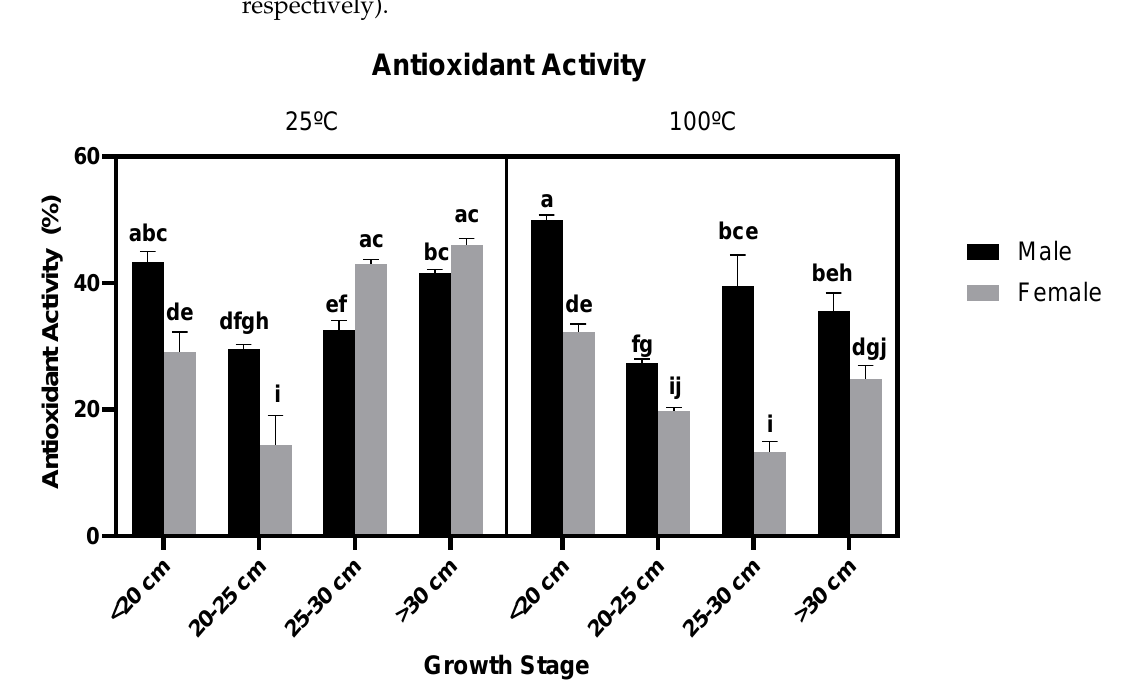
Figure 2. Antioxidant activity represented by the percentage of inhibition of DPPH radical of different F. vesiculosus extracts according to their gender, growth stage and temperature of extraction (25 ◦ C and 100 ◦ C). Different superscript letters (a–j) correspond to values that can be considered statistically different ( p -value ≤ 0.05). A three-way ANOVA was carried out for the statistical analysis between gender, growth stage and temperature of extraction with Tukey’s HSD test for multiple comparisons, represented by the superscripted letters. In all tests, 0.1 mg/mL were used.